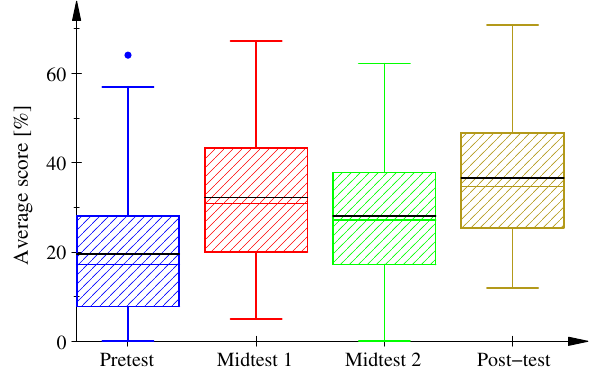
FIG. 2. Box plots of the students ’ scores on all of the CUE tests at OSU. The pretest plot is for N ¼ 85 , the first midtest for N ¼ 86 , the second midtest for N ¼ 69 , the post-test for N ¼ 37 students. The mean (black line) for all tests is slightly higher than the median. The central lines indicate medians for each test and the central box represents 50% of the data. The lower whisker extends to either the smallest value or the 1.5 interquartile range (IQR), whichever is greater (the IQR is calculated as a difference between the third and the first quartiles). The upper whisker extends to either the largest value or the 1.5 IQR, whichever is smaller. For the pretest there was one unusually high score (outlier) represented as a dot at over 60%.